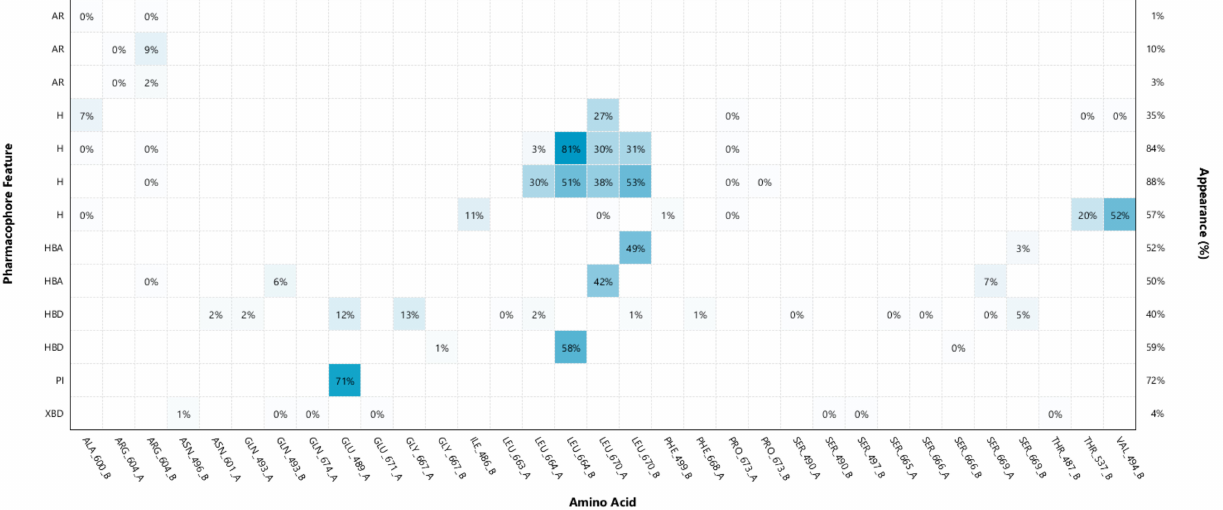
Figure 7. MD Interaction map obtained by analyzing interactions of compound 9i with Hsp90 CTD binding site residues in the 500 ns MD simulation trajectory. Amino acid name and numbering is shown on x-axis, pharmacophore feature type on the left y-axis (H—hydrophobic, HBA—hydrogen bond acceptor, HBD—hydrogen bond donor, PI—positive ionizable, XBD—halogen bond), % appearance on the right